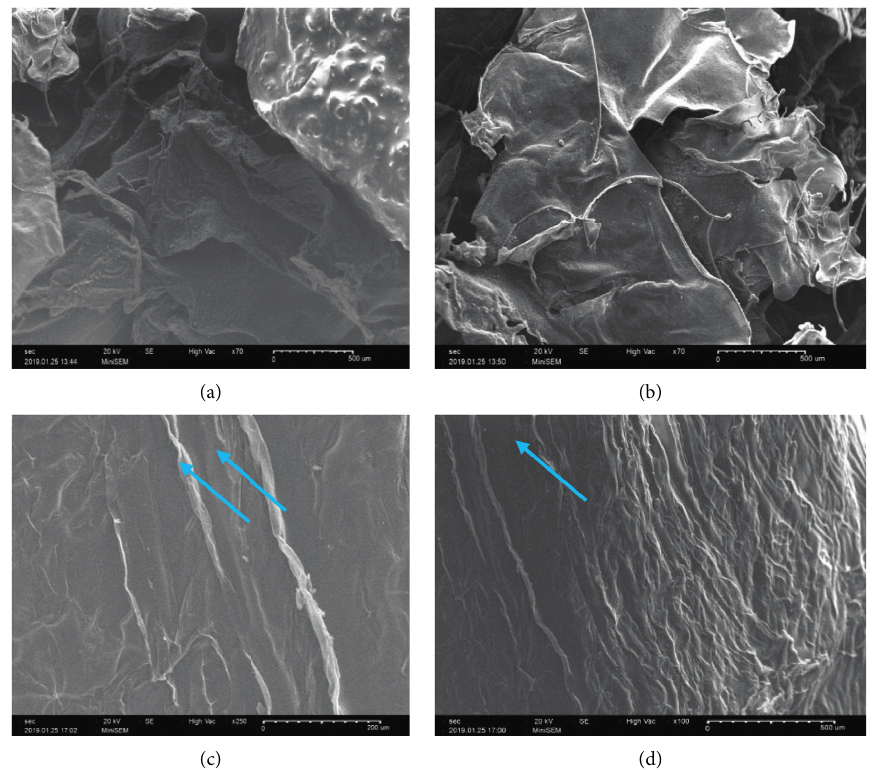
Figure 12: Representative cross-sectional SEM images of lyophilized chitosan salt ((a) and (b)) and chitosan-based hydrogel ((c) and (d)).